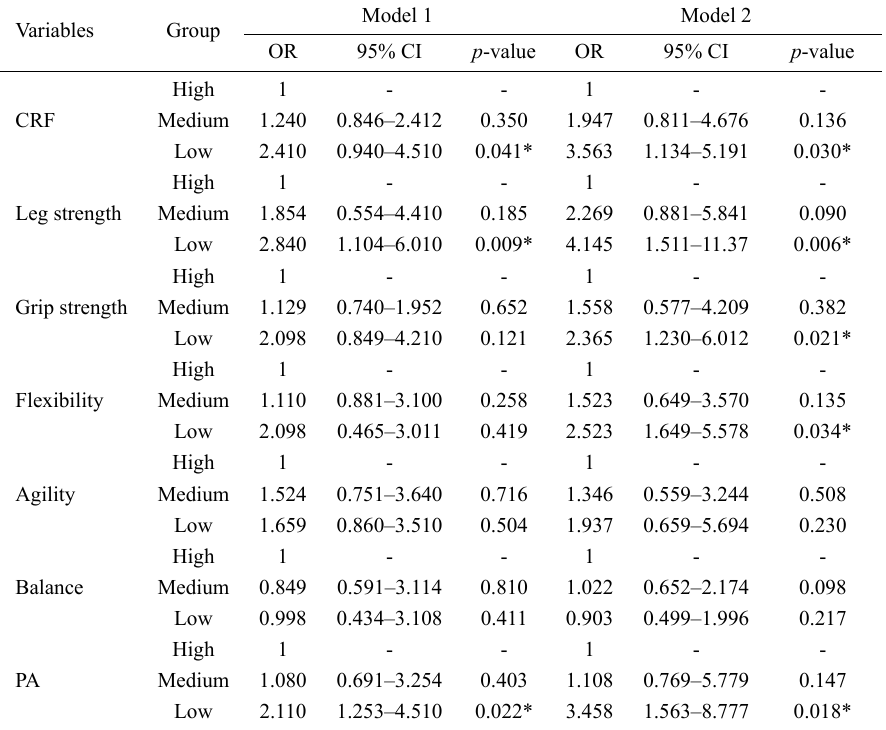
Table 4. VFA obesity prevalence according to physical fitness, physical